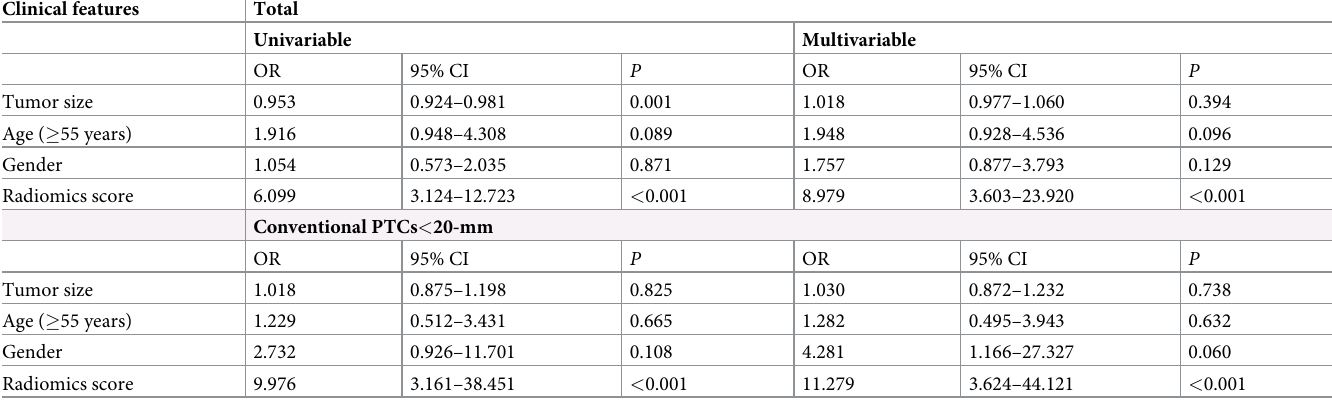
Table 2. Univariable and multivariable analysis in predicting the presence of BRAF V600E mutation in the training cohort of the total thyroid cancers and conven- tional PTC < 20-mm. Clinical